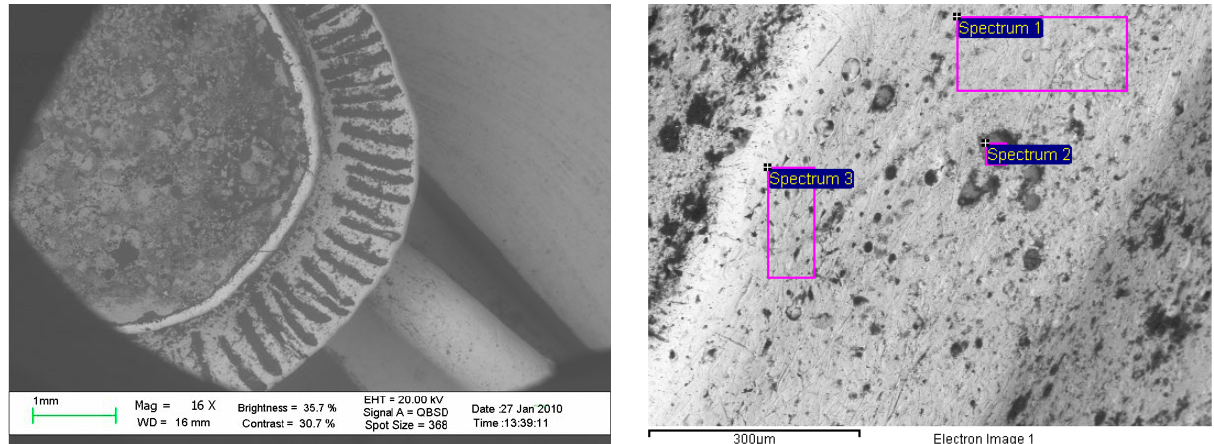
Figure 2. a) Backscattered electrons SEM image, of the part of the bezel with gem b) structure of the glass gemstone with indicated areas analyzed in EDS.